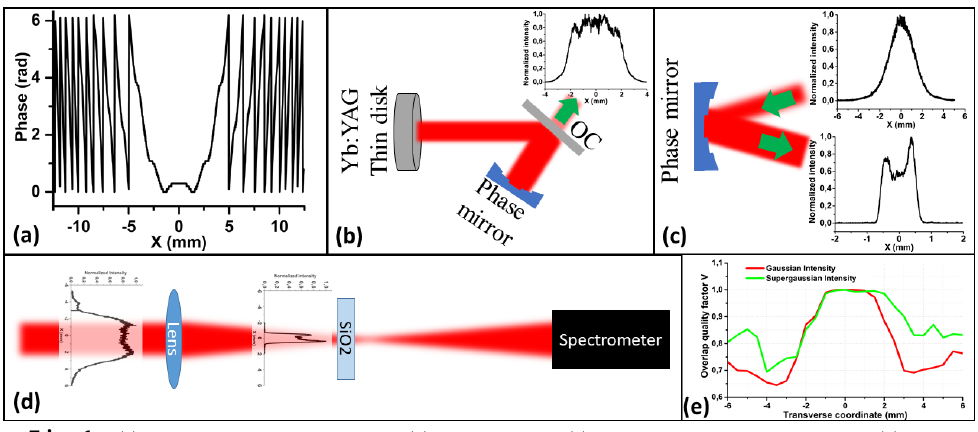
Fig. 1 : (a) Phase mirror phase designed for (b) intra-cavity and (c) extra cavity flat-top beam shaping. (d) Experimental setup for flat-top spectral broadening. (e) Gaussian versus supergaussian spectrum overlap quality